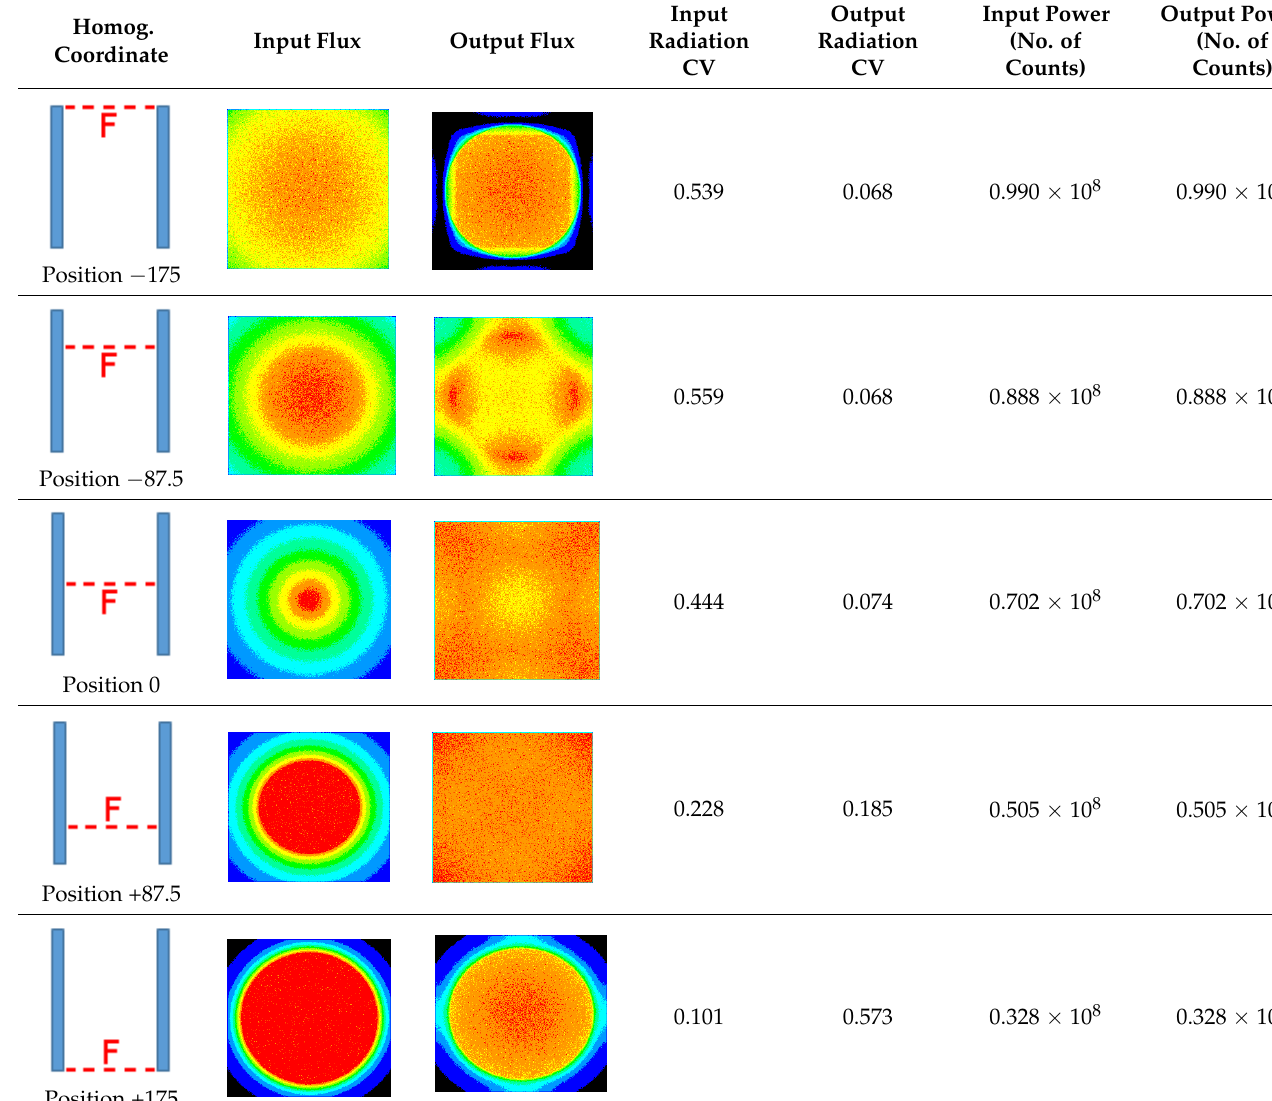
Table 6. Radiation flux, CV, and power at homogenizer entrance and exit, as a function of the position relatively to the theoretical focal point, for the following conditions: Number of faces = 4; total length = 350 mm, tilt angle = 0°. Homog.